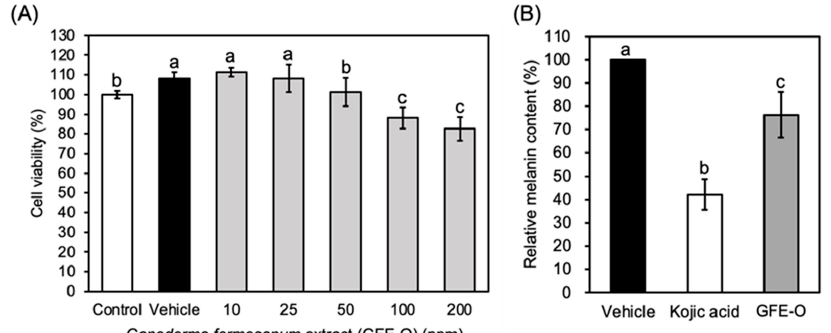
Figure 4. Ganoderma formosanum cultured under optimized fermentation conditions. ( A ) Cell viability of B6-F10 cells treated with G. formosanum extracts obtained from optimal fermentation conditions (GFE-O; 10–200 ppm). ( B ) Relative melanin content of B6-F10 cells treated with kojic acid (50 ppm) and GFE-O (100 ppm). Means with different letters indicate that they are significantly different ( p < 0.05).